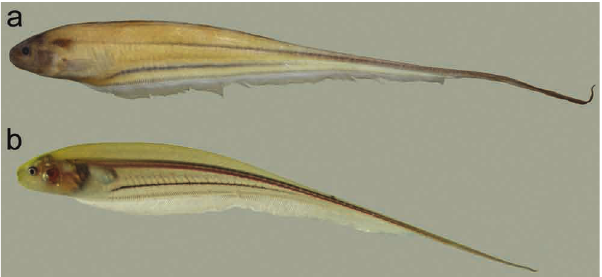
Fig. 2. Left lateral view of fixed specimen (a), MPEG 27068,